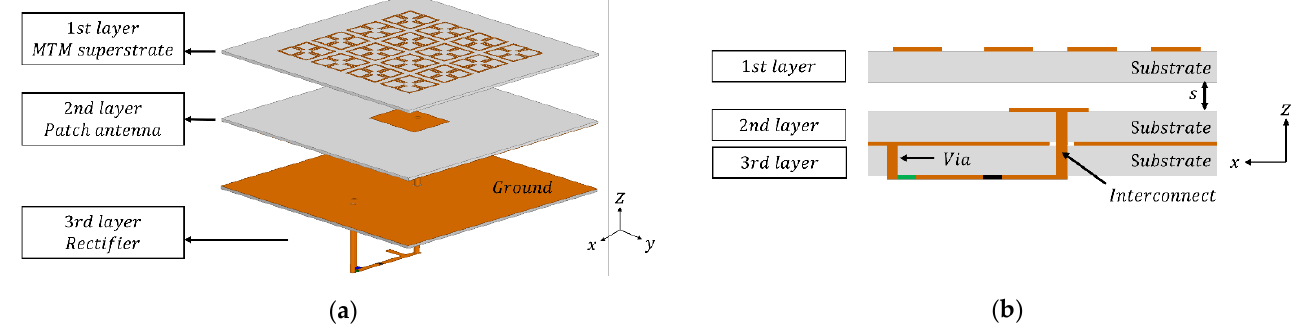
Figure 2. S chematic of a 3D integrated rectenna: ( a ) perspective view, ( b ) side view, where 𝑠 = 10 mm .